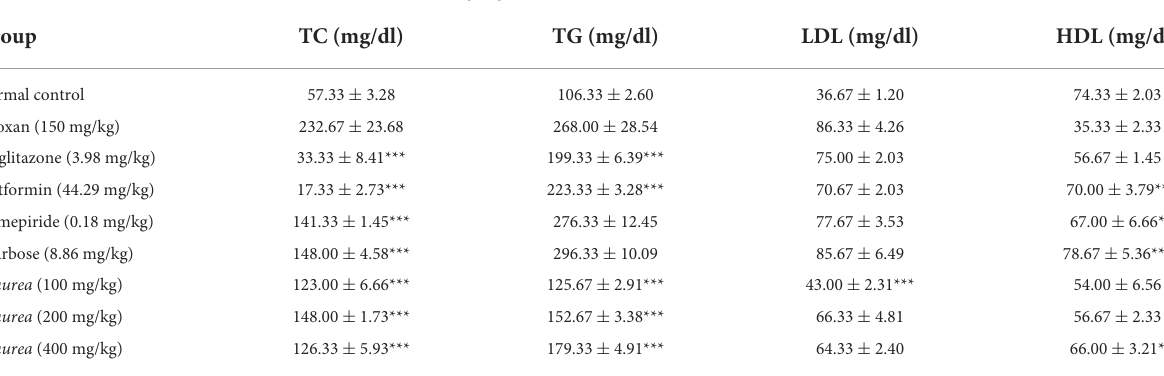
TABLE 2 Effect of B. aurea and standard treatments on the lipid profile of diabetic